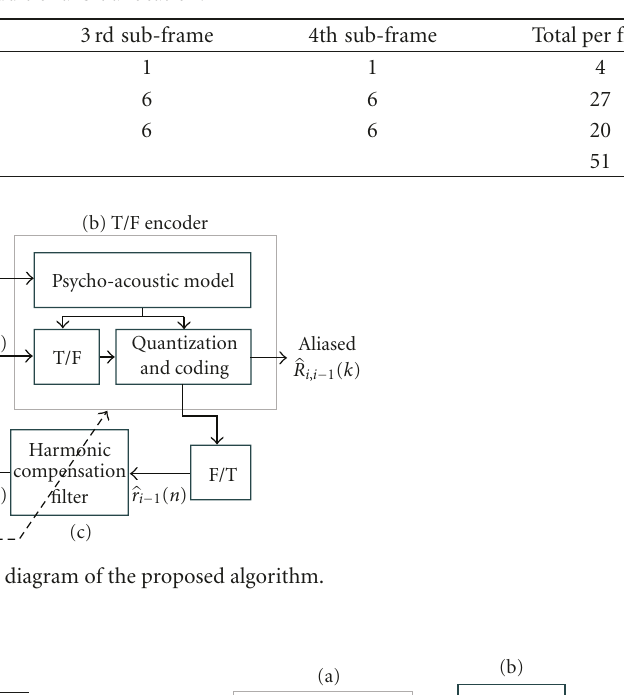
Table 2: Additional bit allocation.